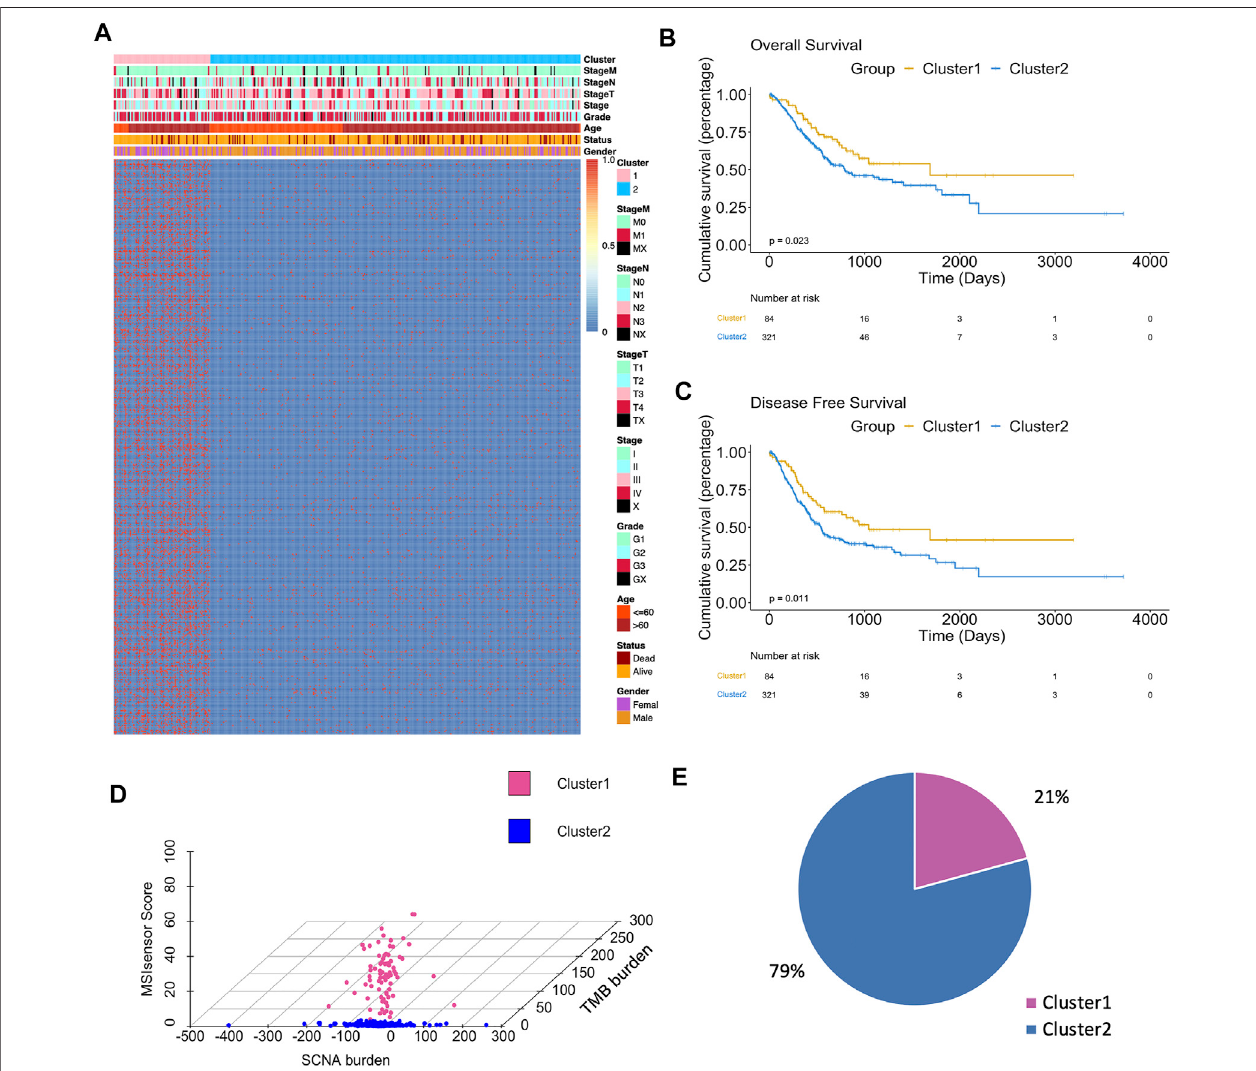
FIGURE 2 | Differences in clinicopathological traits and genomic features between two clusters. (A) Heatmap showed clusters of 500 genomic mutation pro fi les. Sampleannotationsshowtheclinicopathologicalcharacteristics. (B) Kaplan – MeierplotsshowedtheOSinpatientsinCluster1andCluster2( p < 0.05). (C) Kaplan – Meier plots showed the DFS in patients in Cluster1 and Cluster2 ( p < 0.05). (D) 3D plot showed the difference in samples between two clusters. (E) Sample percentage of the two